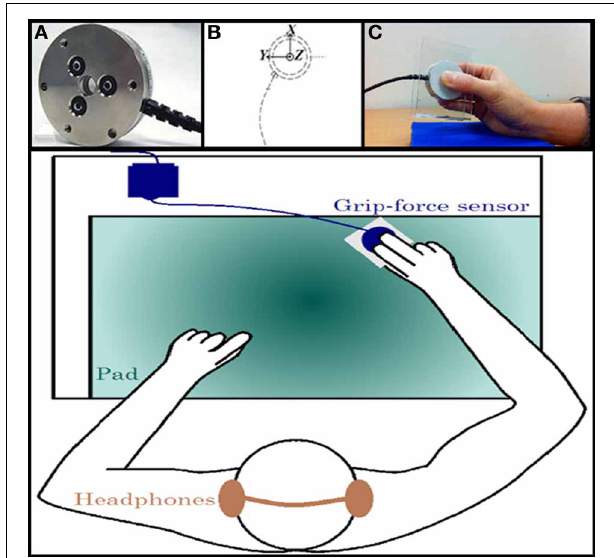
FIGURE 1 | Experimental material and setting. (A) A standalone 6-axis load cell of 68g was used (ATI Industrial Automation, USA). (B) The three main forces were recorded: Fx, Fy, and Fz as the longitudinal, radial and compression forces, respectively. (C) Participants hold the grip-force sensor in a precision grip with their right hand. Bottom panel: participants wore headphones and were comfortably seated behind a desk on which a pad was placed. They were asked to rest their arms on the pad, holding the